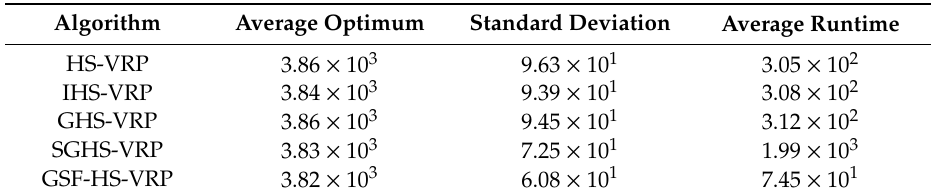
Table 8. Comparison results at fixed iteration times.